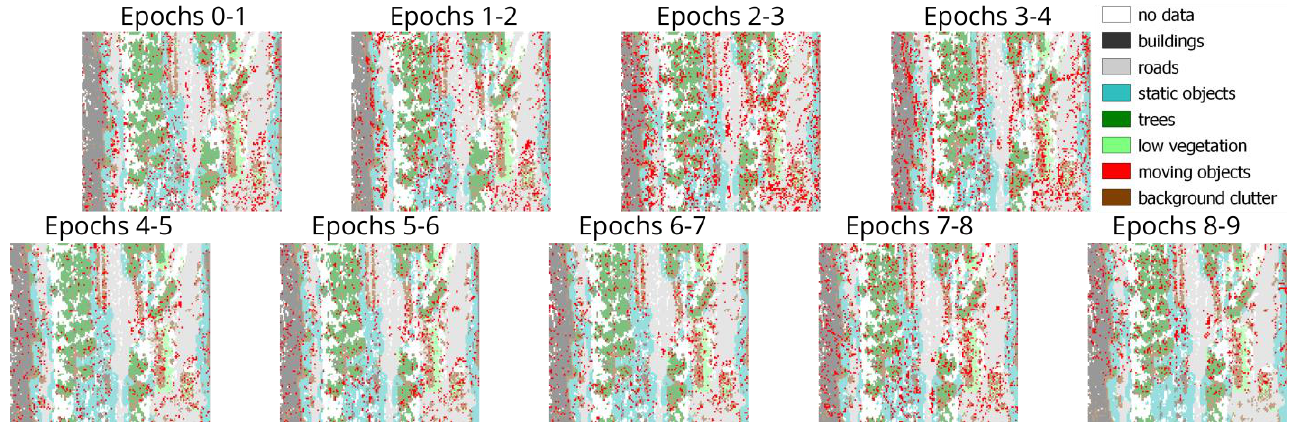
Figure 10 . Final segmentation: moving objects varying in consecutive epochs are highlighted in